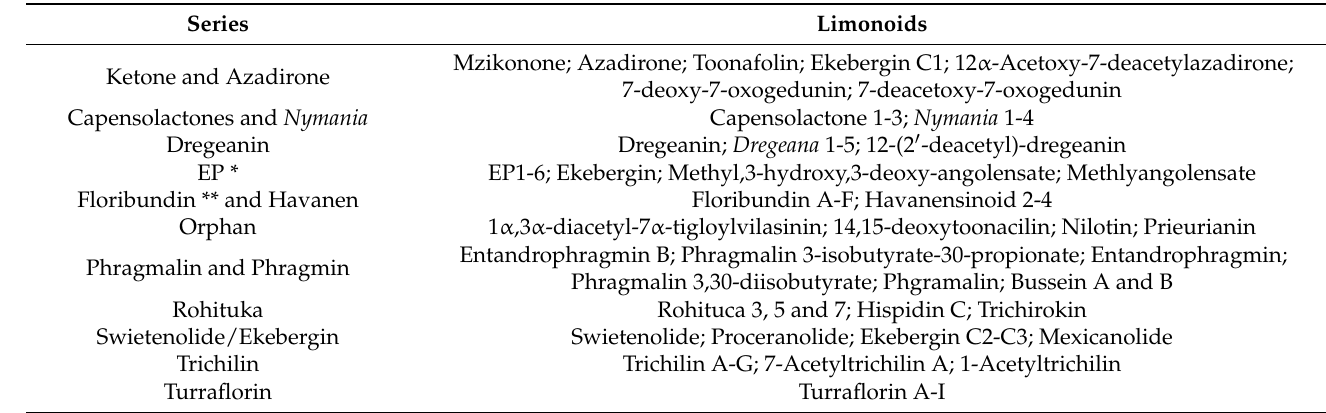
Figure 5. Number of compounds, classes of compounds and references for each species of South African Meliaceae. Table 4. Reported limonoids according to